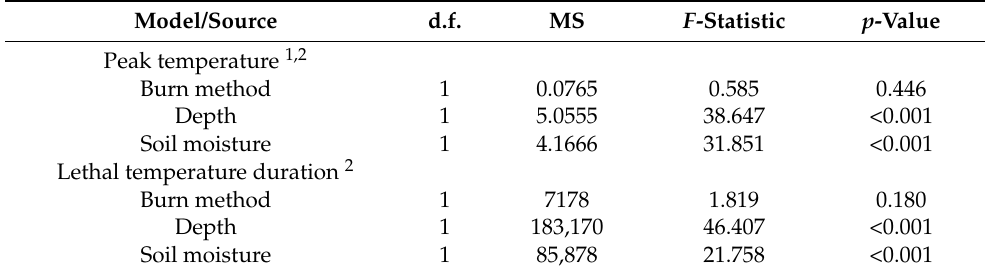
Table 2. Test results of analysis of variance for peak temperature and lethal temperature duration.